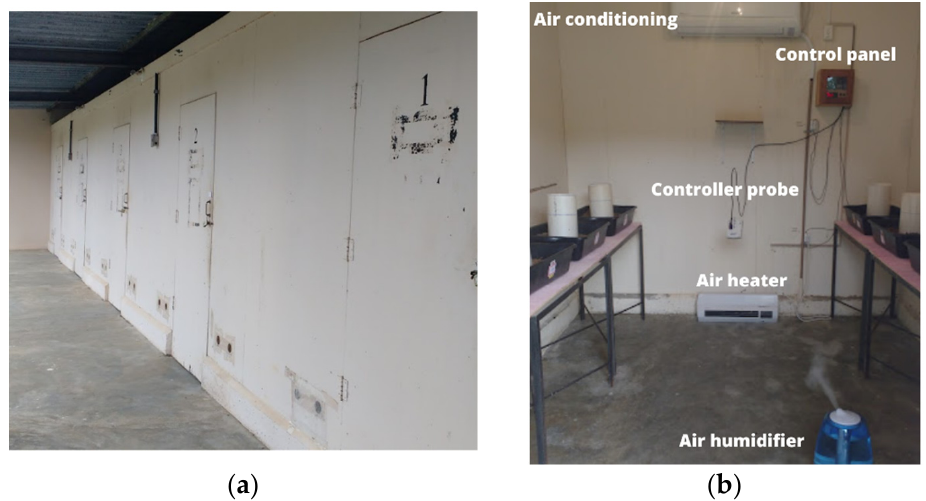
Figure 3. Images from climatic chambers; ( a ) external view and ( b ) internal view with the main equipment